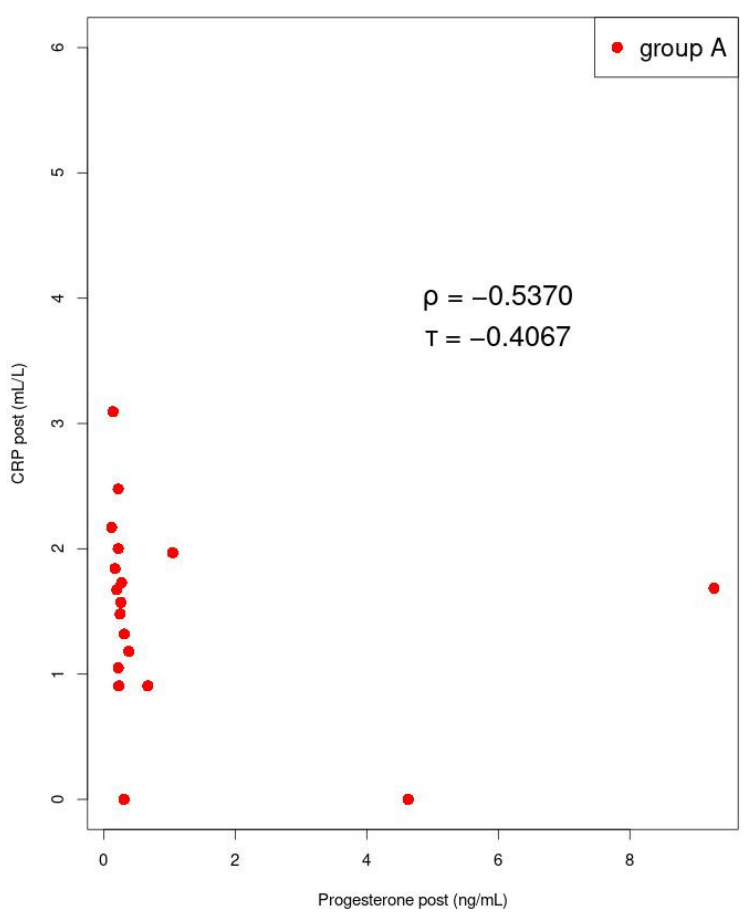
Figure 8. Correlation between progesterone and CRP. Kendall’s tau ( τ ) values and Spearman’s rank correlation rho ( ρ ) are shown. The determined values of the coefficients are statistically significant.